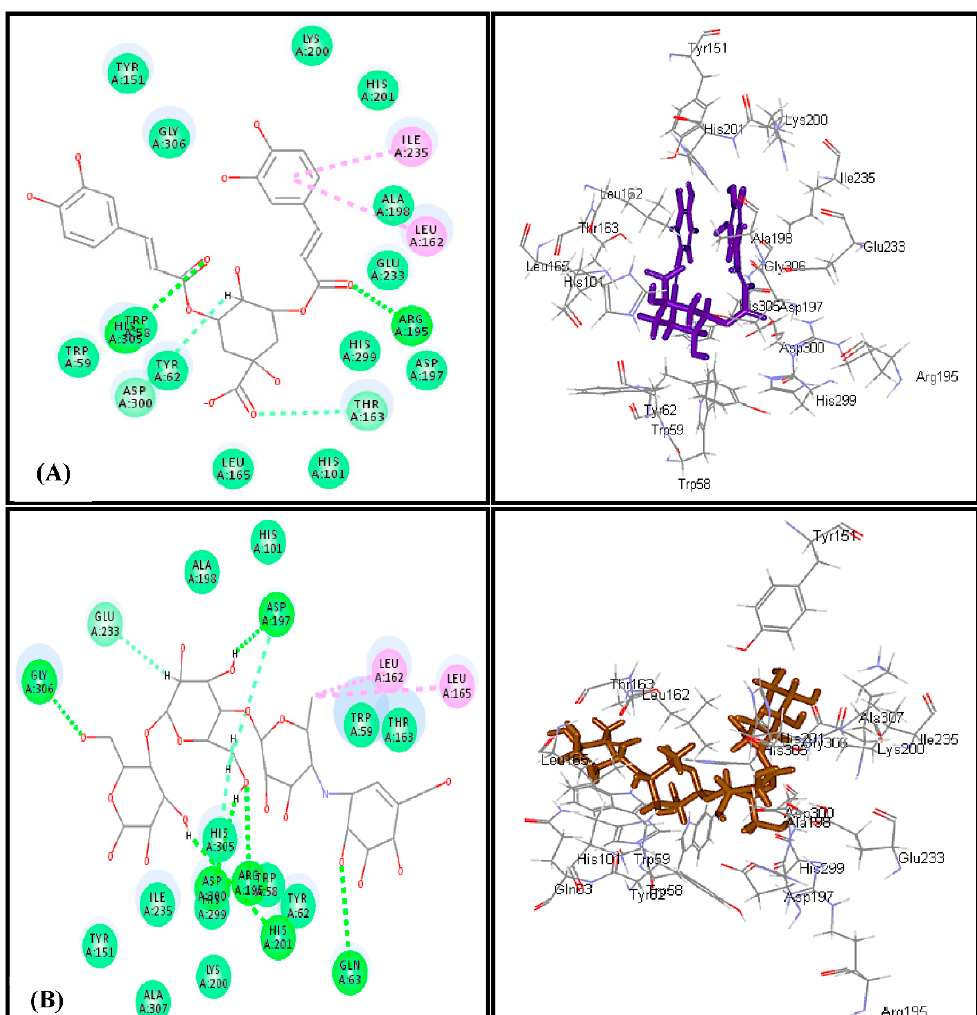
Figure 5. 2D and 3Dbinding modes of dicaffeoylquinic acid ( A ) and acarbose ( B ) within human amylase (HA) active centers employing C-docker protocol.